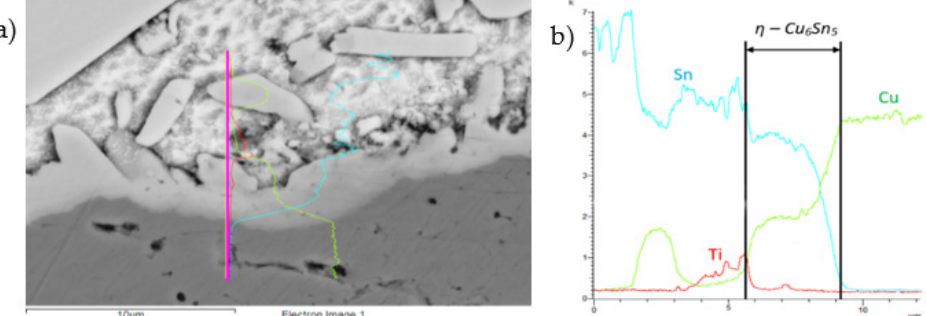
Figure 23. The line EDX analysis of the Cu–SiC/Sn5Sb3Ti joint; ( a ) transition zone with a marked line; ( b ) concentration profiles of Sn, Sb, Ti, and Cu elements.